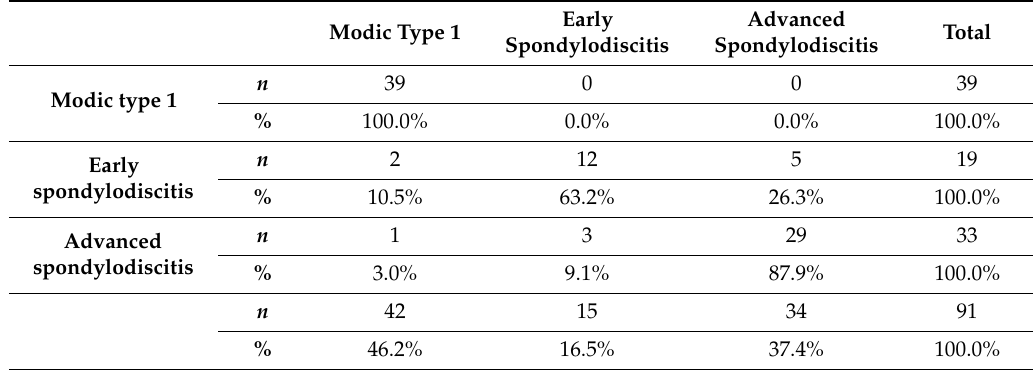
Table 5. Percentages of correct classification of MT1, and early and advanced spondylodiscitis based upon the combined features of edema extent, T1-w signal ratio, and endplate contour.